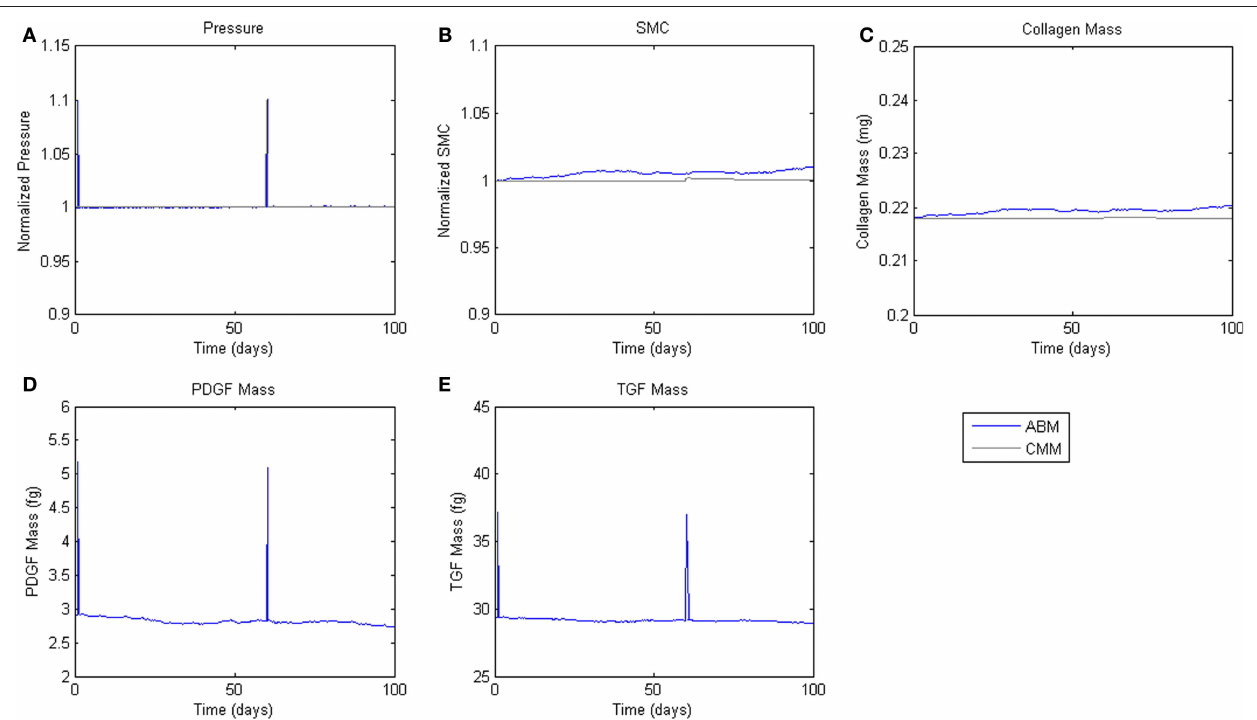
Figure 5 | Transient Pressure increases. ABM results are shown in blue, CMM results in black. ABM results are an average of 100 simulations. Transient increases in pressure of 10% for 6 h drive short-term changes in growth factor expression, but not SMC mass or collagen production. (A) Pressure, (B) SMC, (c) Collagen, (D) PDGF-AB, (e) TGF-